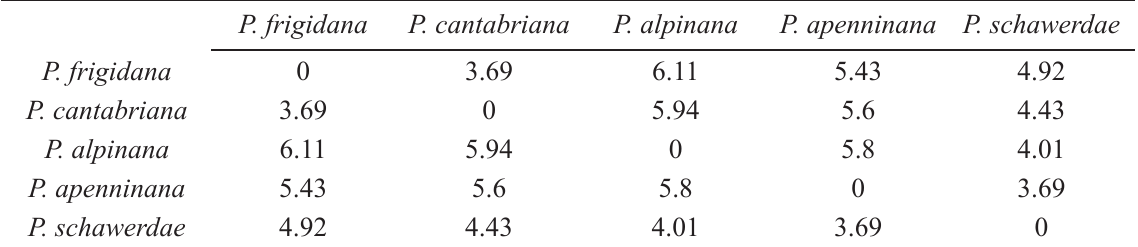
Table 1. Minimal uncorrected COI p-distances between different taxa of the P. frigidana s. lat. species